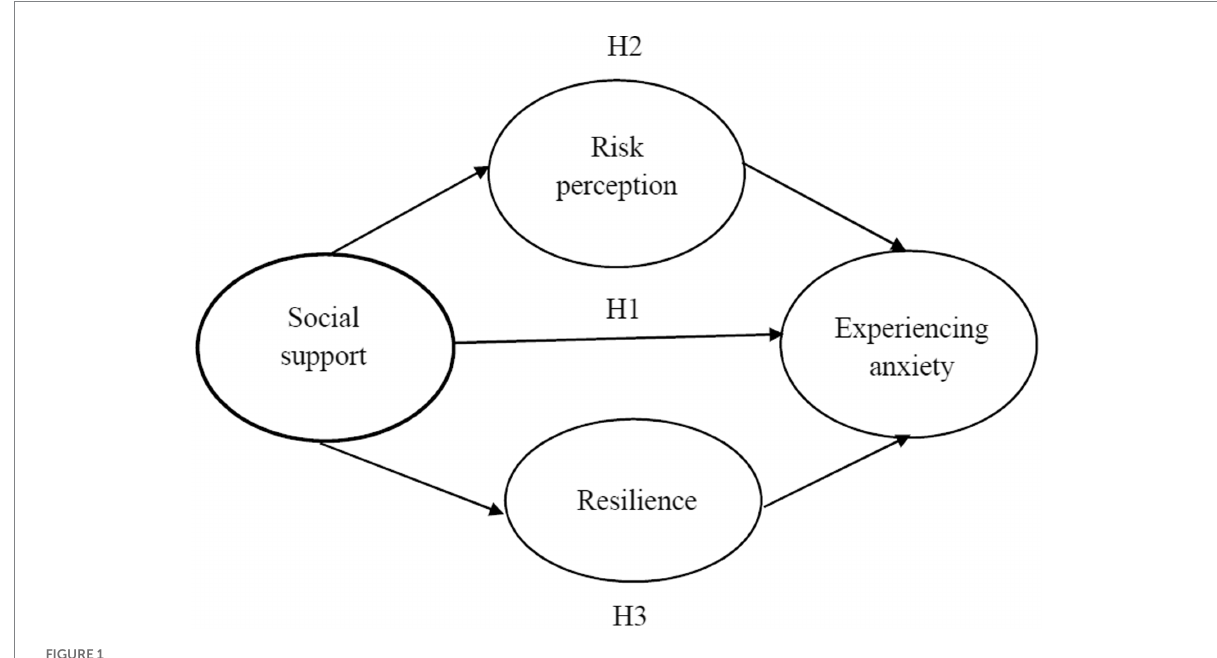
FIGURE 1 Hypothetical model.